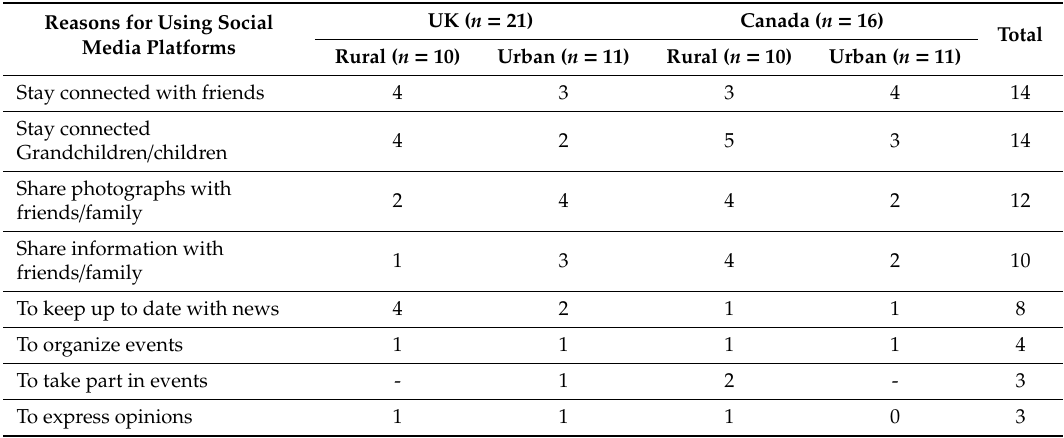
Table 5. Purpose for using social media ( n = 37) by country (UK and Canada) and location (rural and urban).